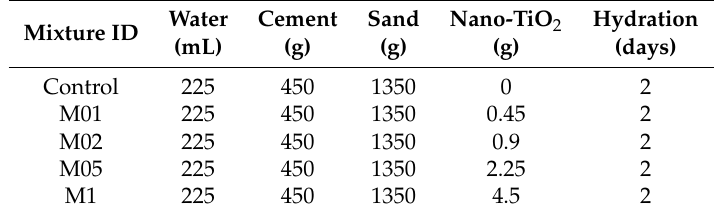
Table 3. Mix proportion of the specimens prepared for photocatalysis